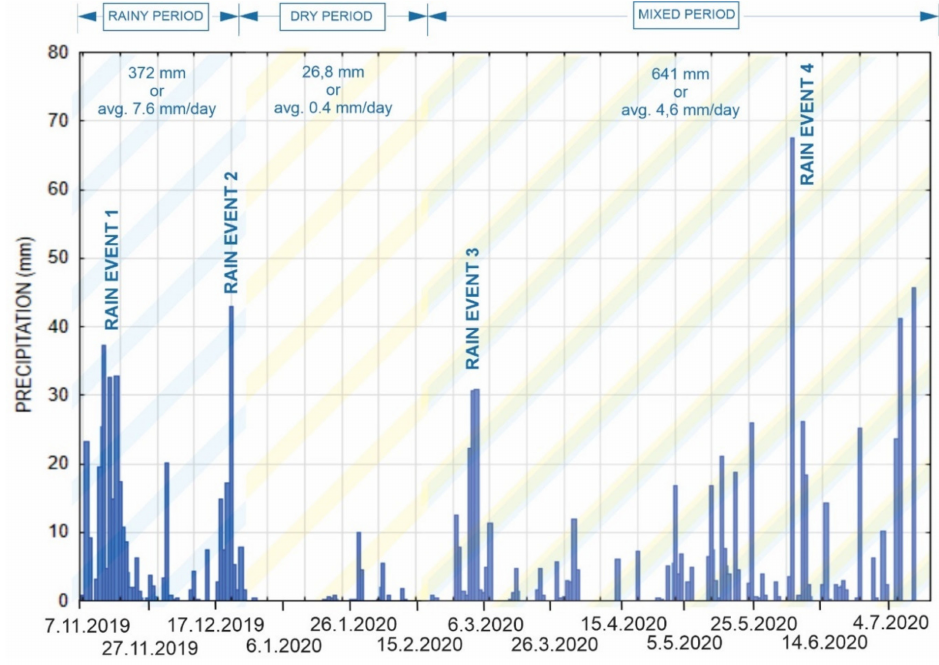
Figure 12. Precipitation detected during the observation period (7 November 2019–14 July